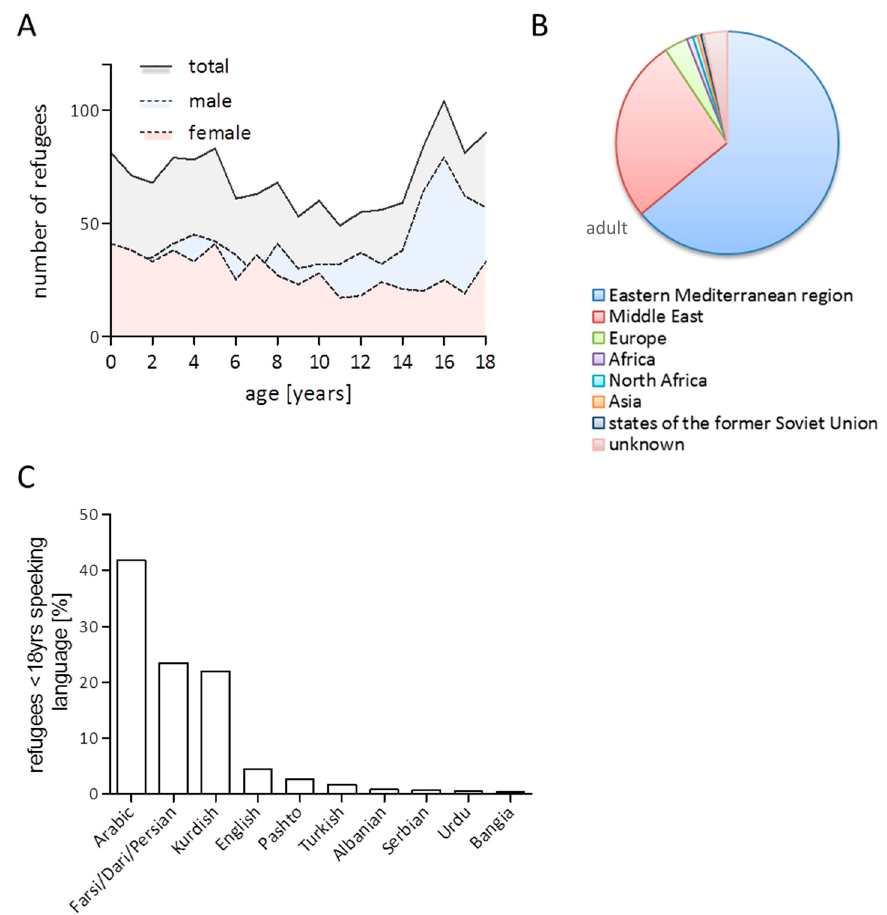
Figure 1. Age and gender distribution ( A ), regions of origin ( B ), and spoken language ( C ) within the analyzed cohort of refugees below the age of 18 years.